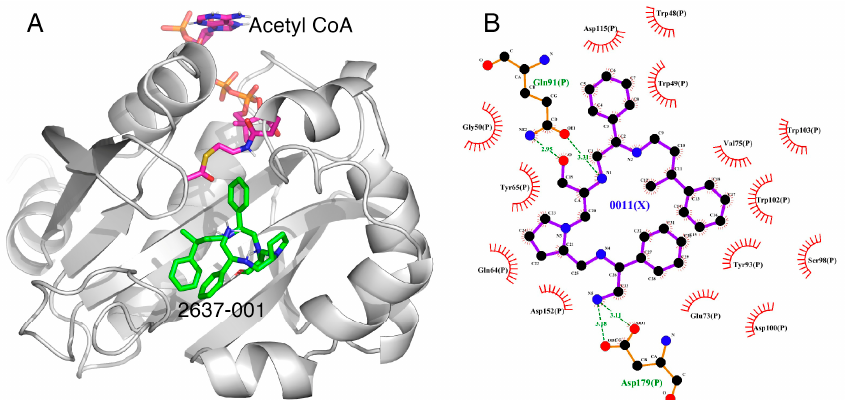
Figure 1. ( A ) The complex of 2637.001 and AAC(6 (cid:48) )-Ib obtained from molecular docking. The bound acetyl CoA is also shown. ( B ) Interaction map of the ligand in its binding site of the AAC(6 (cid:48) )- Ib receptor. The map shows the hydroxyl functionality interaction with Gln91 and the primary amine of 2637.001 hydrogen bonding with Asp179. The pictures show the top-ranked, lowest- energy